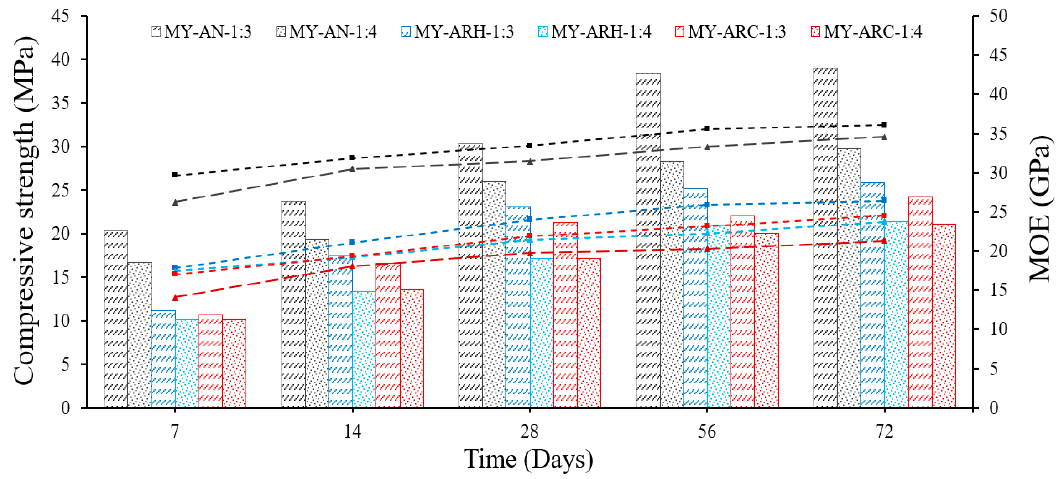
Figure 10. The evolution of the compressive strength (bars) and dynamic Young’s modulus (dotted lines) measured over time for the di ff erent dosages